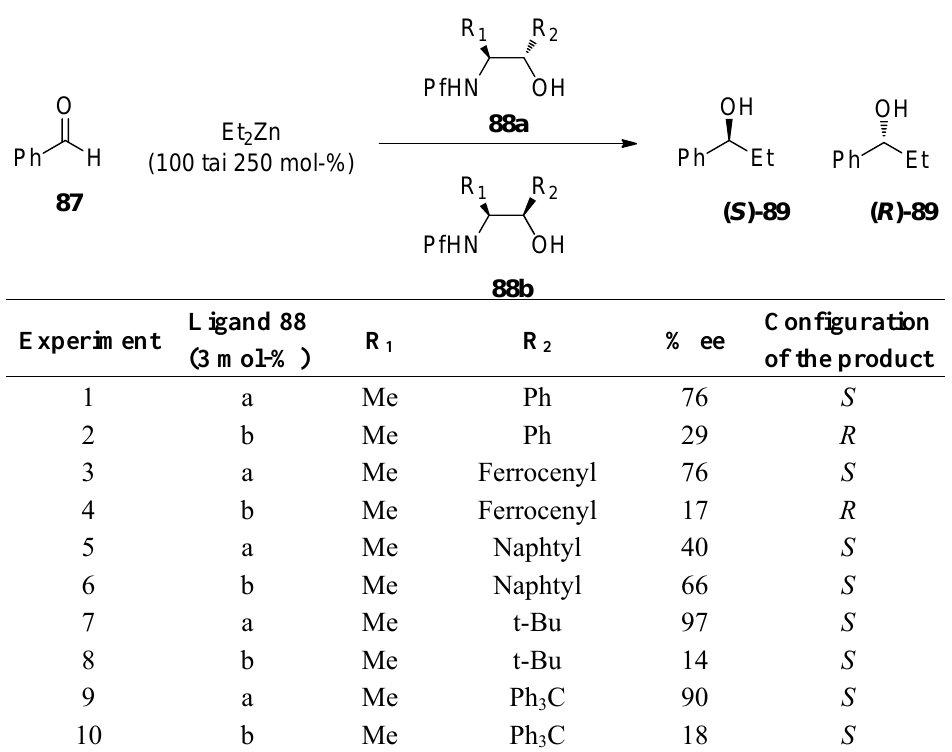
Zn-catalyzed addition to benzaldehyde. 2